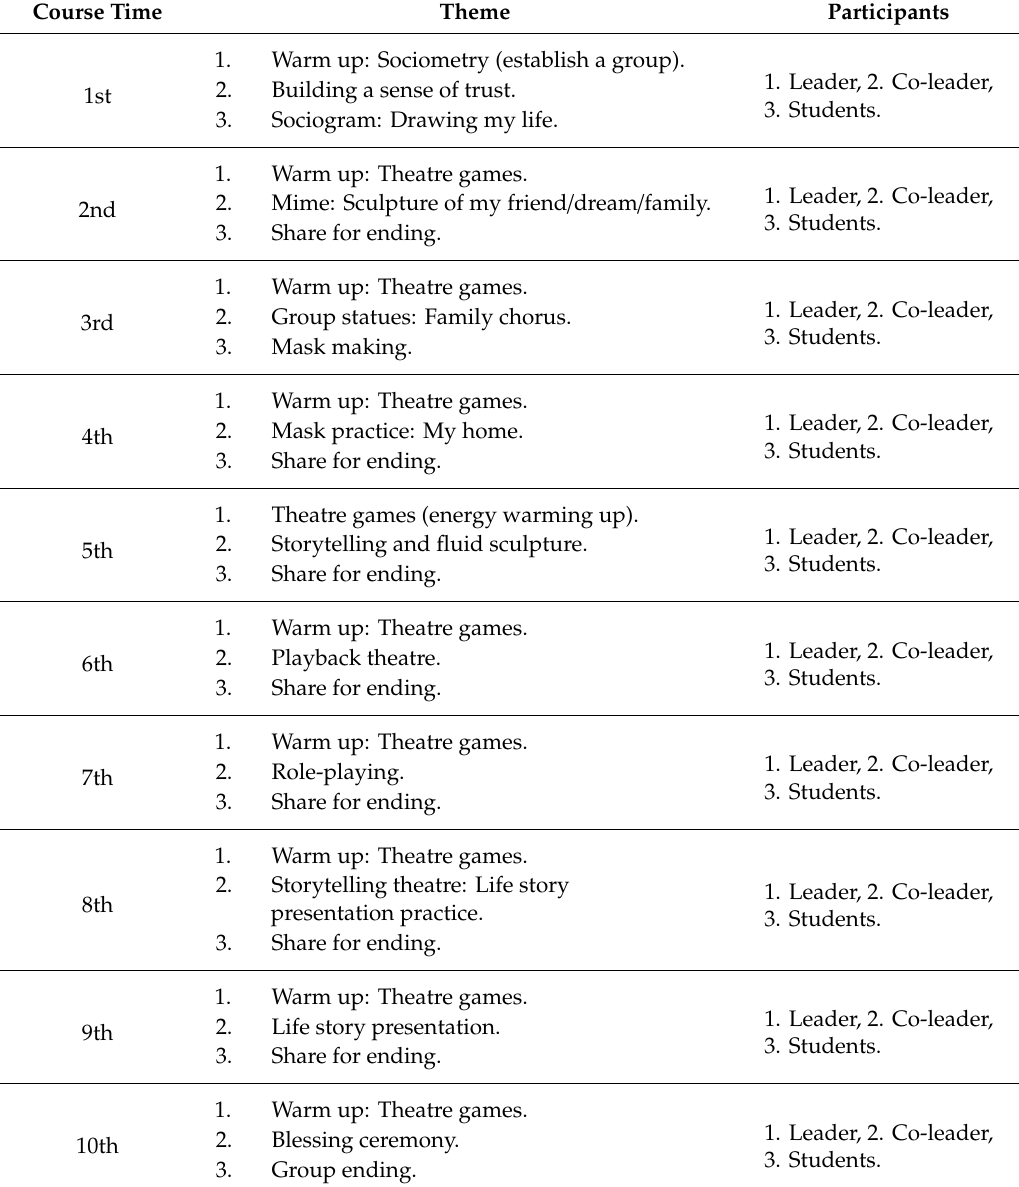
Table 2. Drama therapy student counseling group course